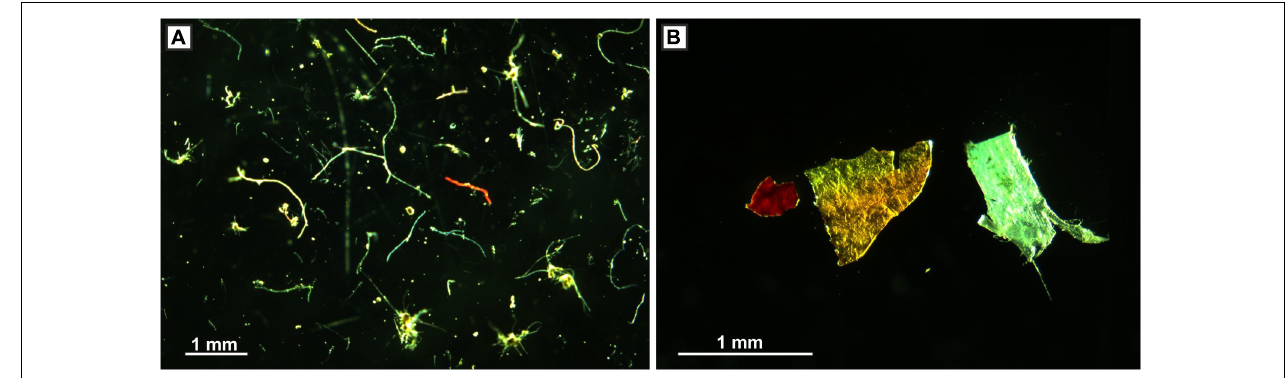
FIGURE 1 | (A) Microplastic fibers and (B) microplastic fragments; both from seafloor cores, c. 800 m water depth, Tyrrhenian